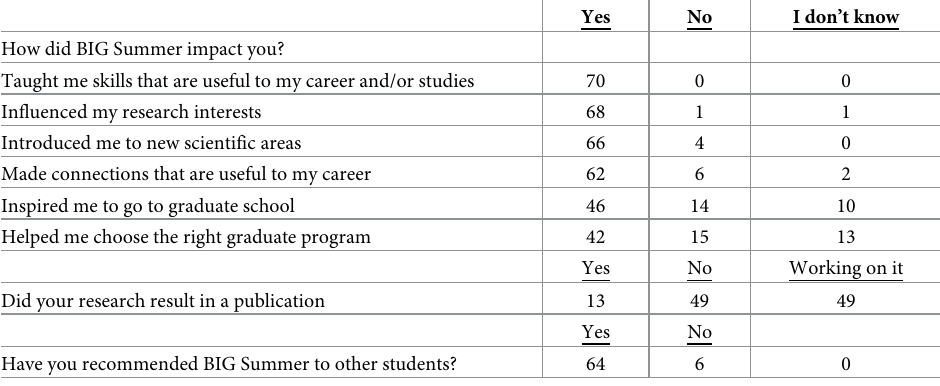
Table 1. Bruins in Genomics Summer survey